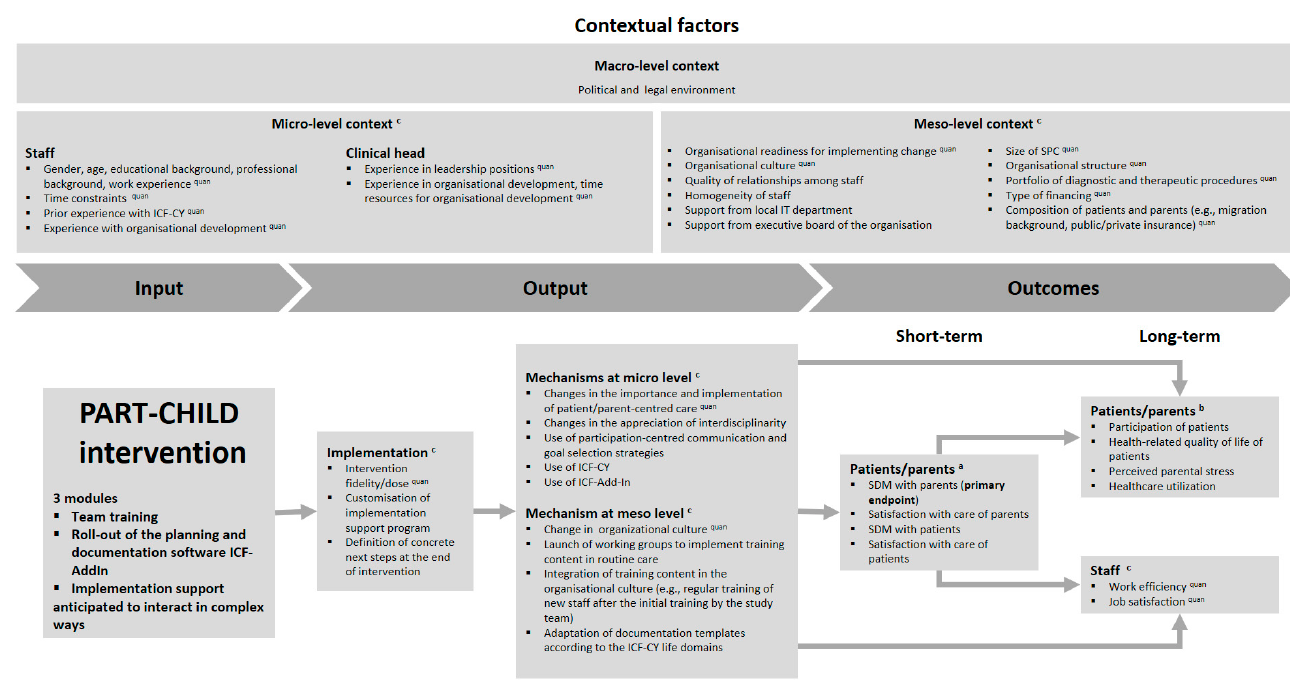
Figure 4. Logic model of the PART-CHILD intervention. We distinguish between (1) contextual factors, (2) inputs, (i.e., the components of the PART-CHILD intervention), (3) outputs and (4) both short- and long-term outcomes. These aspects are covered in the quantitative a cross-sectional and b cohort component of the effectiveness evaluation and the qualitative and quan quantitative c process evaluation. Macro-level contextual factors are not covered in the evaluation, but are considered when interpreting the findings of the trial. ICF-CY, International Classification of Functioning Disability and Health–Child and Youth Version; SDM, shared decision making; SPC, social paediatric